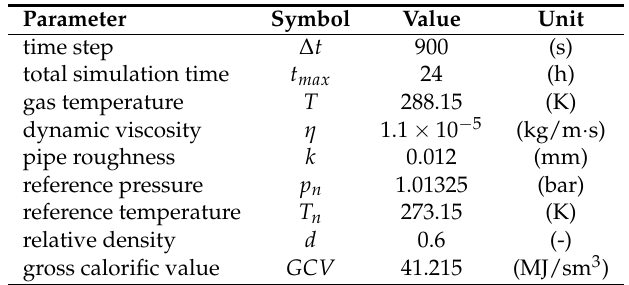
Table 6. Input data for the gas